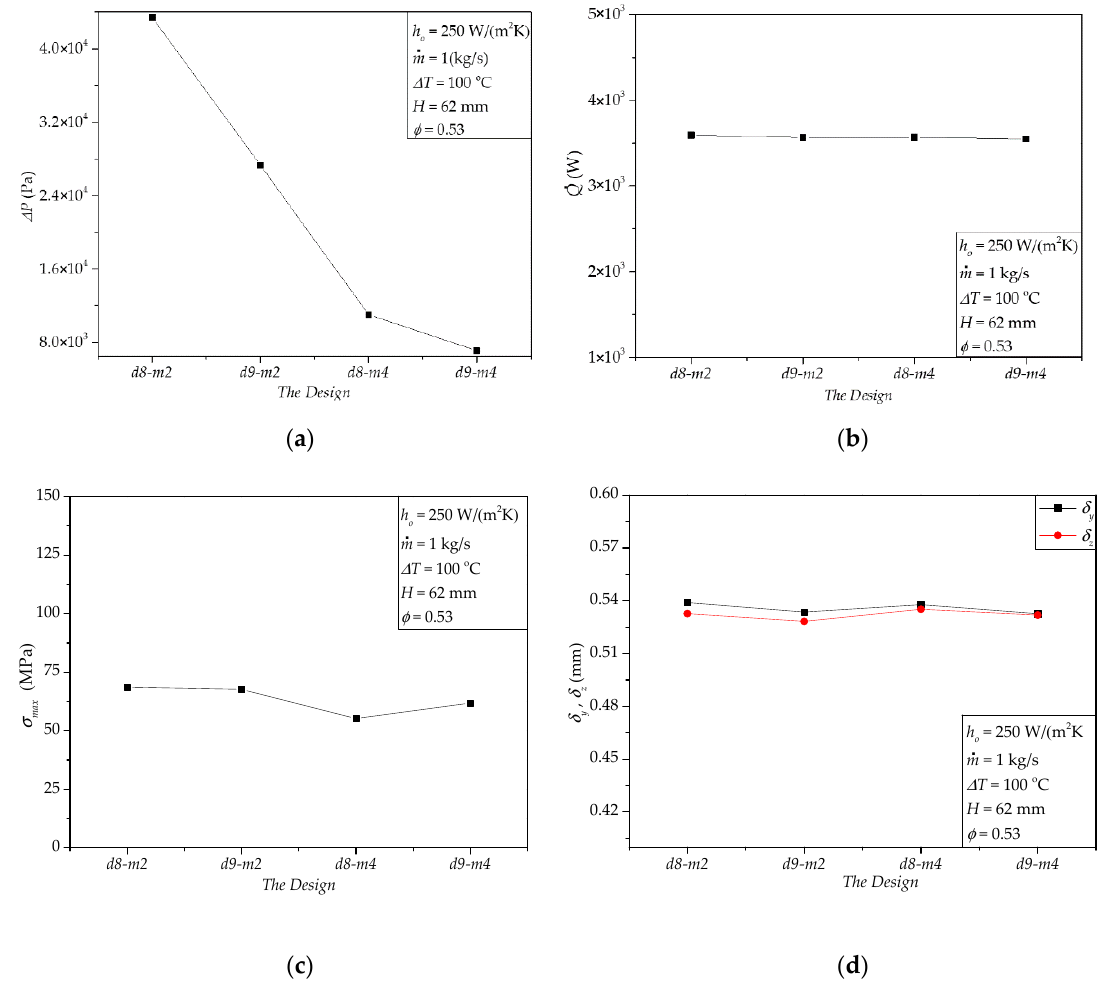
.  Q Q , ( c ) σ max , ( d ) δ y , δ z , ( c ) σ max , ( d ) δ y , δ z .